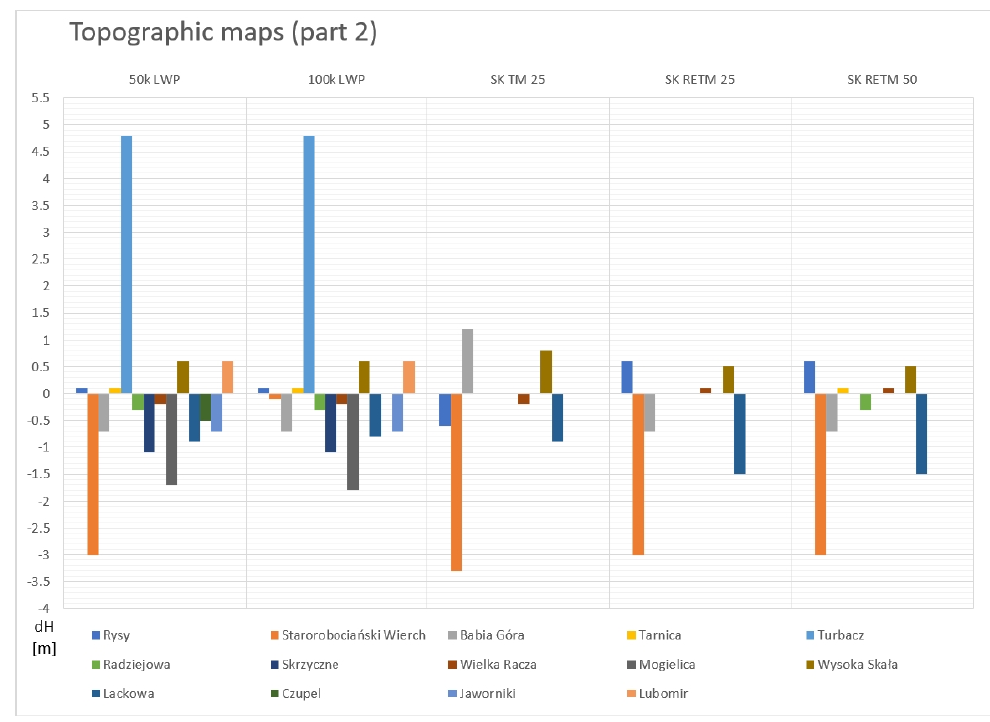
Figure A5. Height difference with GNSS surveying for civil and military topographic maps (Polish and Slovak) (part 2). Source: authors.